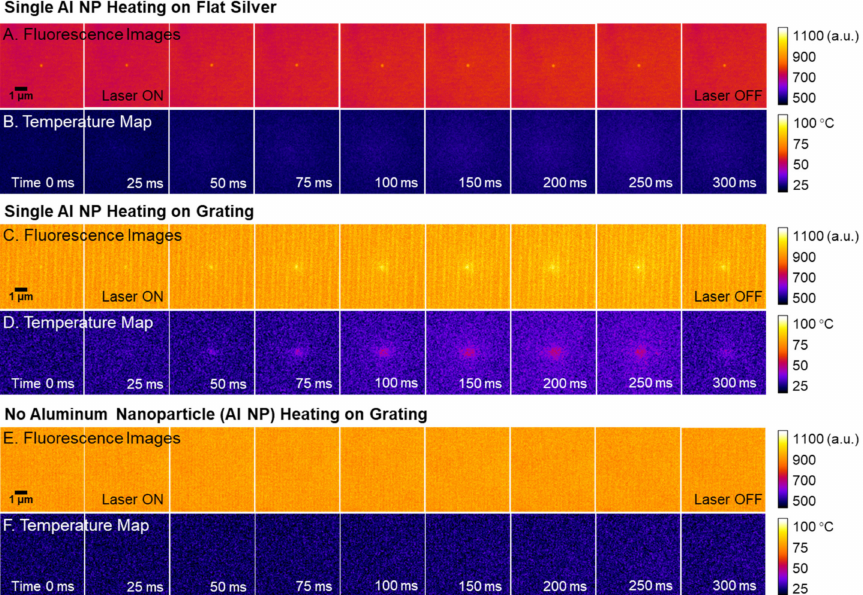
Figure 4. The time sequence of fluorescence intensity and temperature during laser irradiation was shown in the false colored images. Heating of single nanoparticle embedded in a 1 µ m Al/THV/R6G film and supported on ( A , B ) flat silver and ( C , D ) plasmonic grating substrates indicating rapid localized heating followed by rapid cooling after the laser is turned off. ( E , F ) The laser also irradiated Al/THV/R6G film on a grating substrate with the absence of Al